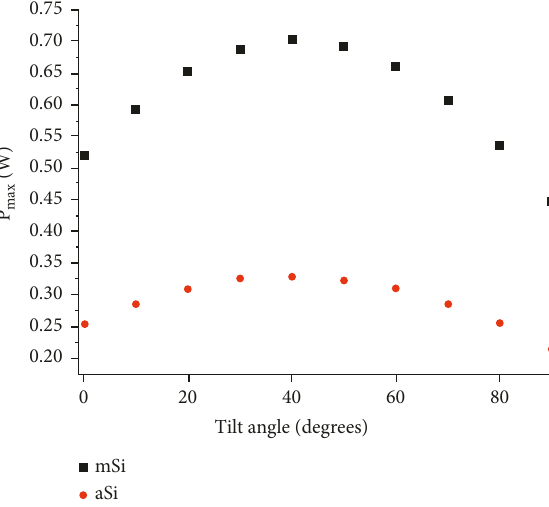
Figure 3: Maximum power generated from the photovoltaic panels.